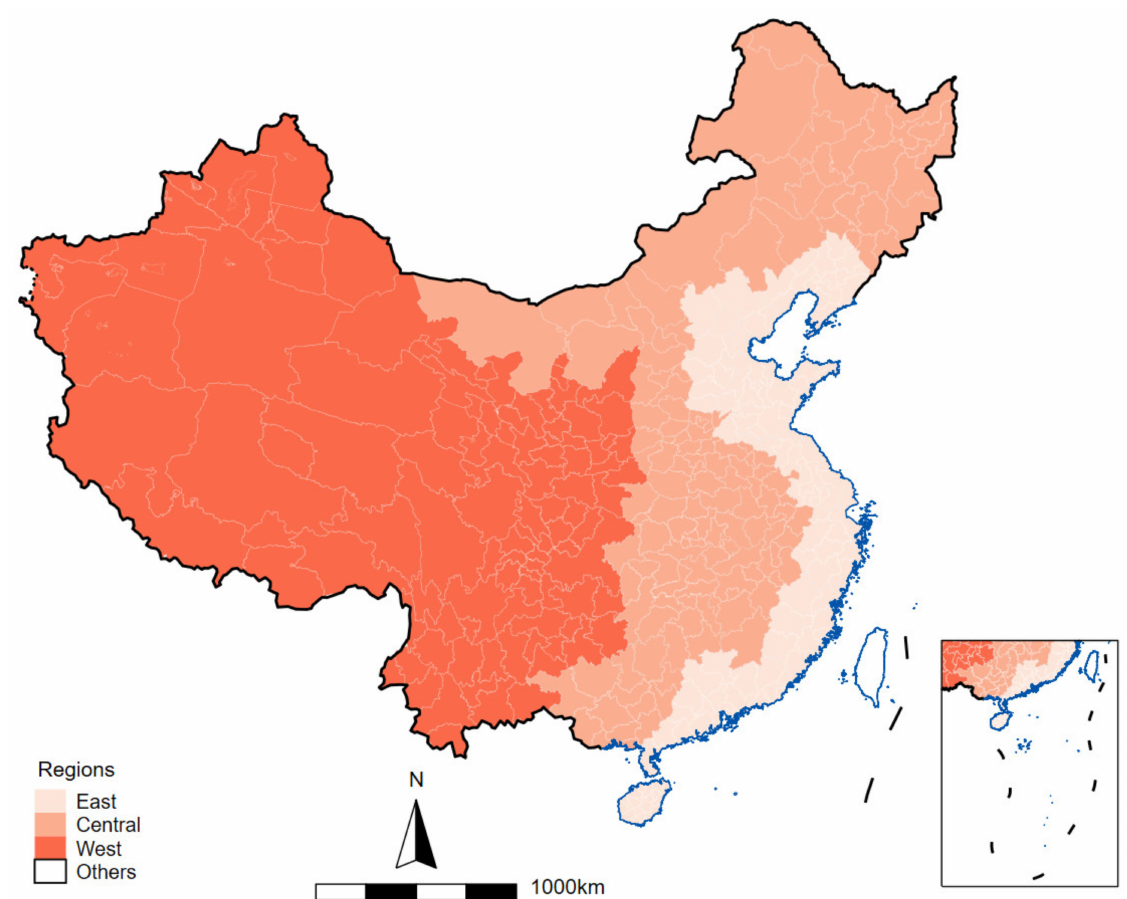
Figure 3. Division of Western, Central, and Eastern